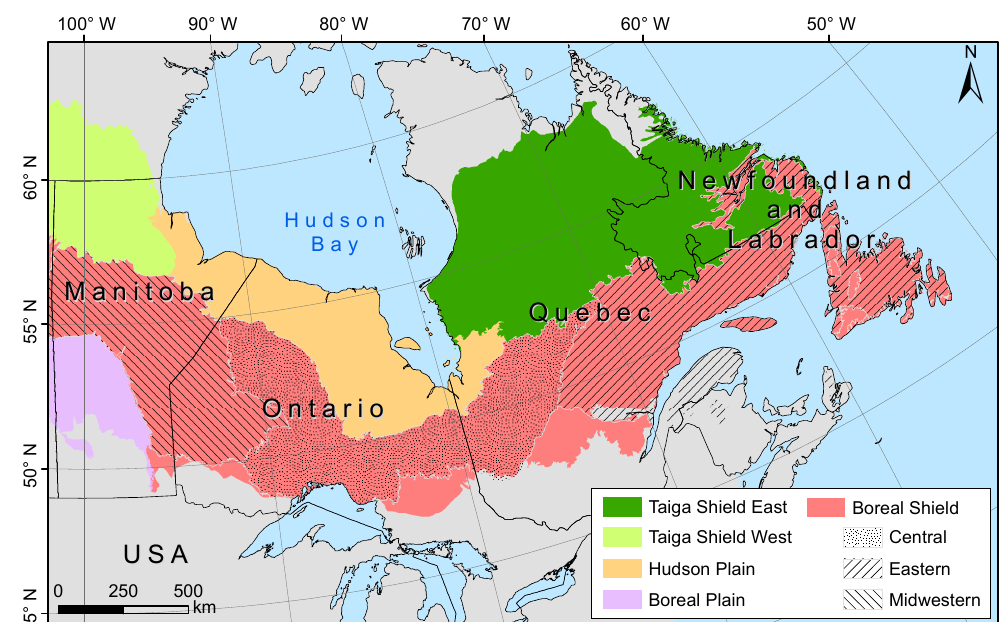
Figure 1. Map of eastern Canada’s boreal forest from Manitoba to Newfoundland showing ecozones in colour. The Boreal Shield ecozone is divided into three ecoregions: Eastern Canadian forests, Central Canadian Boreal Shield forests, and Midwestern Canadian Shield forests.